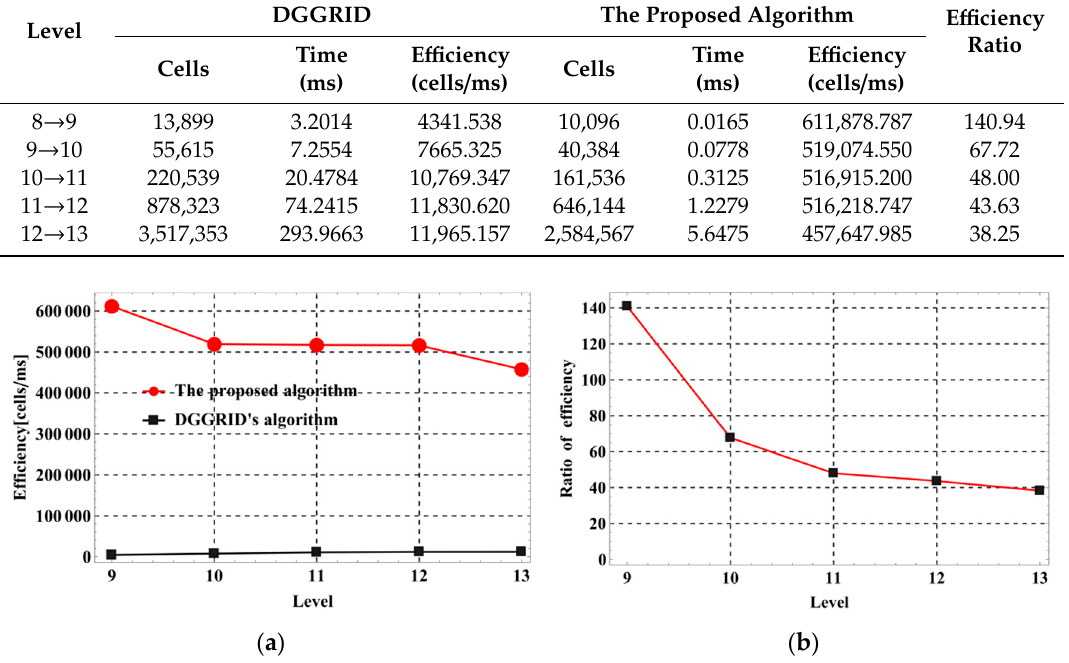
Figure 11. Efficiency comparison line charts for single-level indexing: ( a ) absolute value and ( b ) ratio. Table 2. Results of the hierarchical indexing e ffi ciency comparison experiment. Table 2. Results of the hierarchical indexing efficiency comparison experiment.